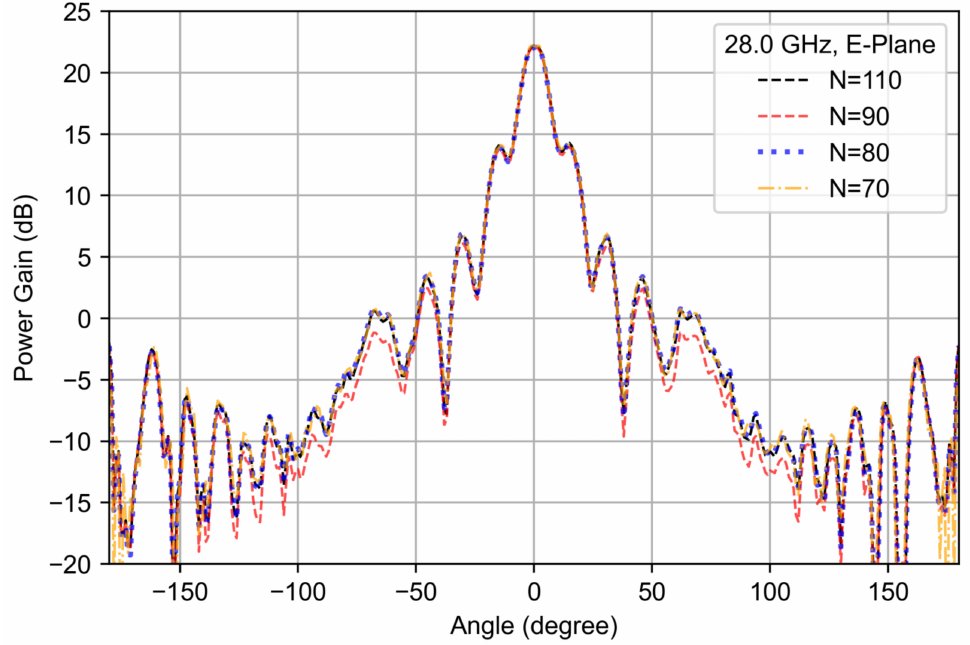
Figure 13. Measurement result of the hon antenna at 28 GHz for different sampling